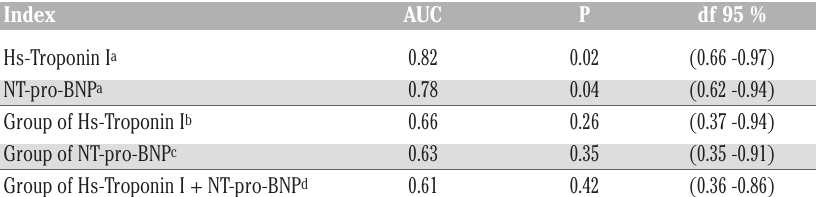
Table 4. Analysis of Under the Curve Area of each index.